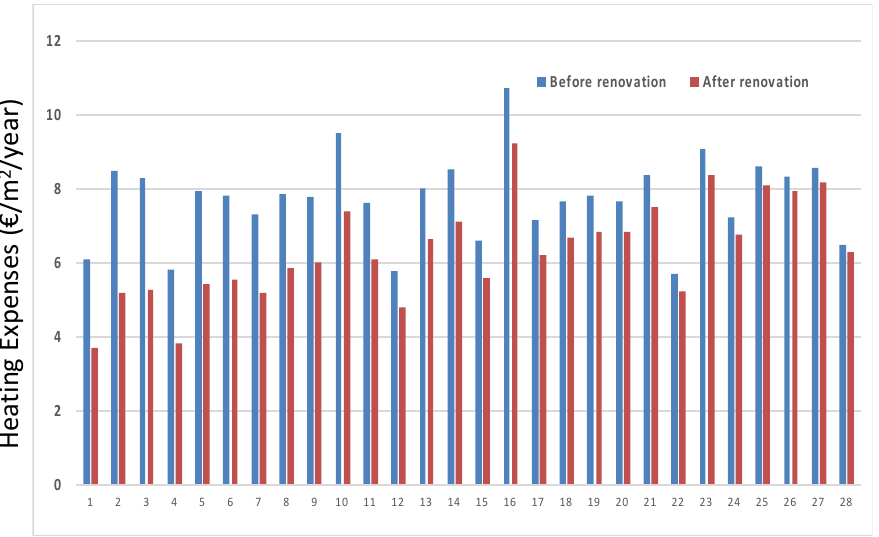
Figure 4. Impact of renovation of Category D buildings on the heating expenses.